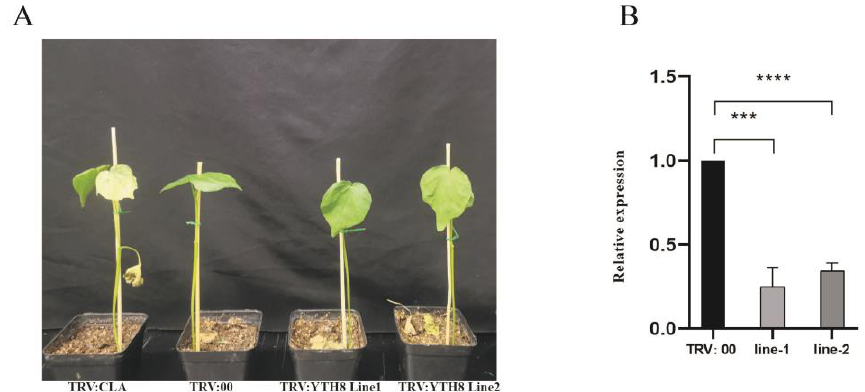
Figure 11. Functional verification of GhYTH8 under drought stress. ( A ) Whole plant phenotypes of gene-silenced plants. The plant with CLA-silencing, the negative control plant, and two plants with GhYTH-silencing are displayed from left to right. ( B ) The expression level of GhYTH in empty control and VIGS plants under drought stress. *** and **** indicate the significant differences between the TRV::00 and TRV:GhYTH8 lines determined by Student’s t -test.